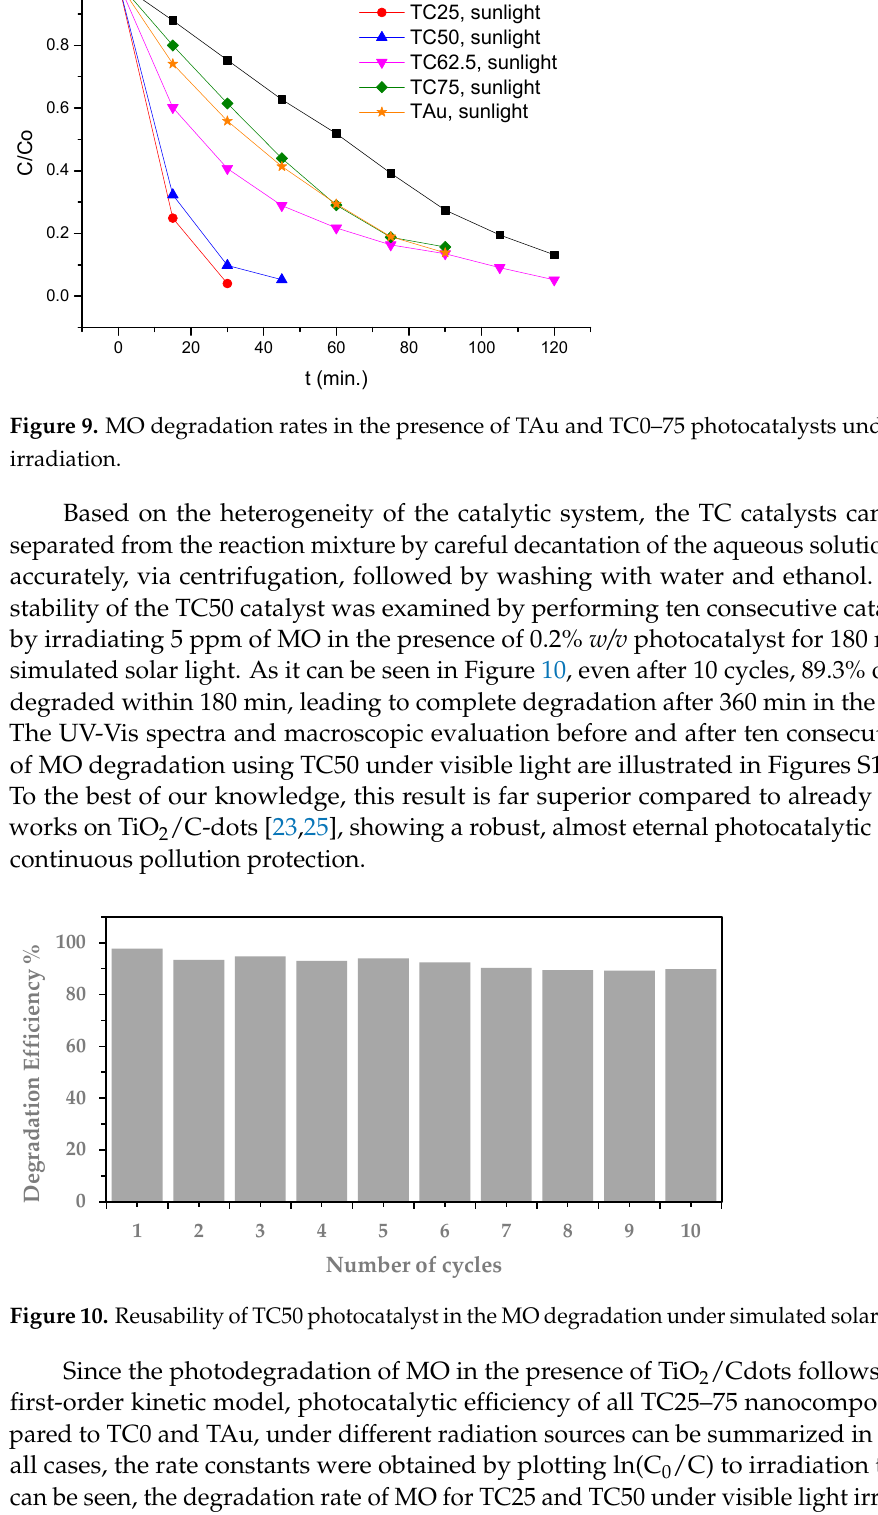
Table 1. Comparison of photocatalytic efficiency between TC0–75 and TAu using the first order fitting kinetic data of MO degradation under different radiation sources.